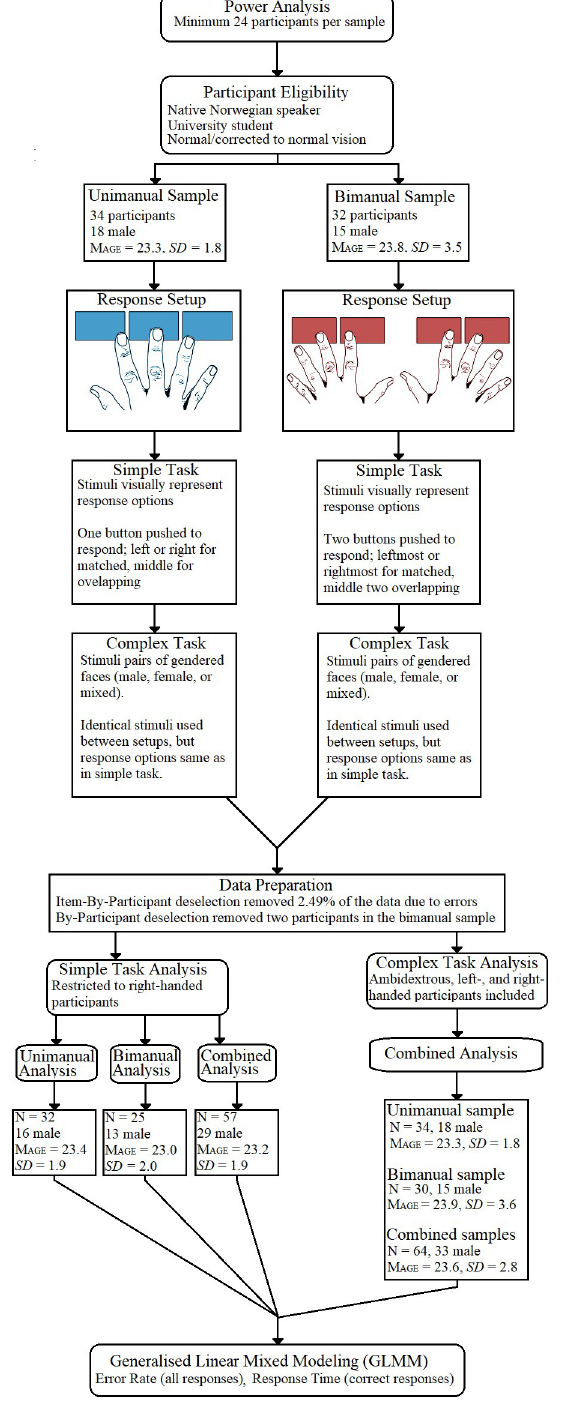
Fig 2. Flowchart presenting the experimental